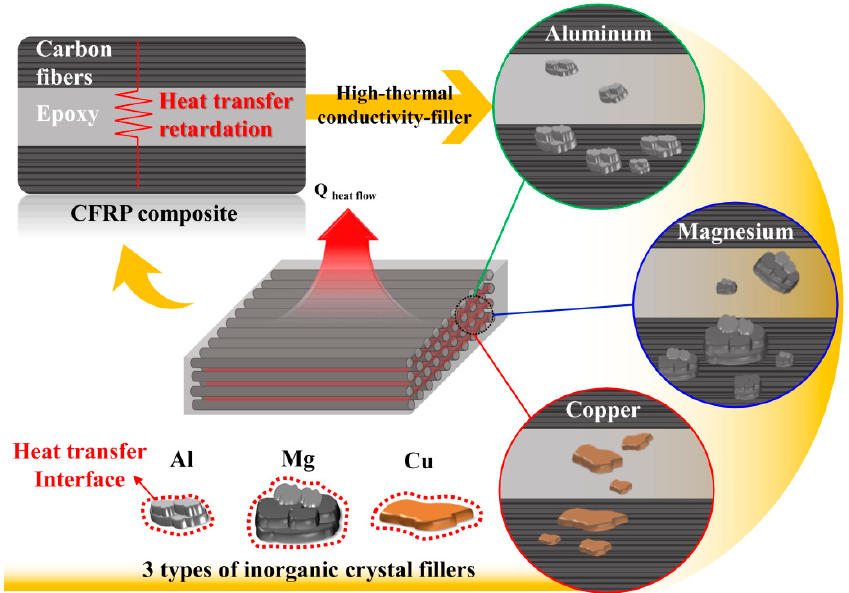
Figure 1. Schematic diagram of the preparation of the high thermally conductive carbon fiber-reinforced polymer (CFRP) composites with inorganic crystal fillers using a layer-by-layer coating.